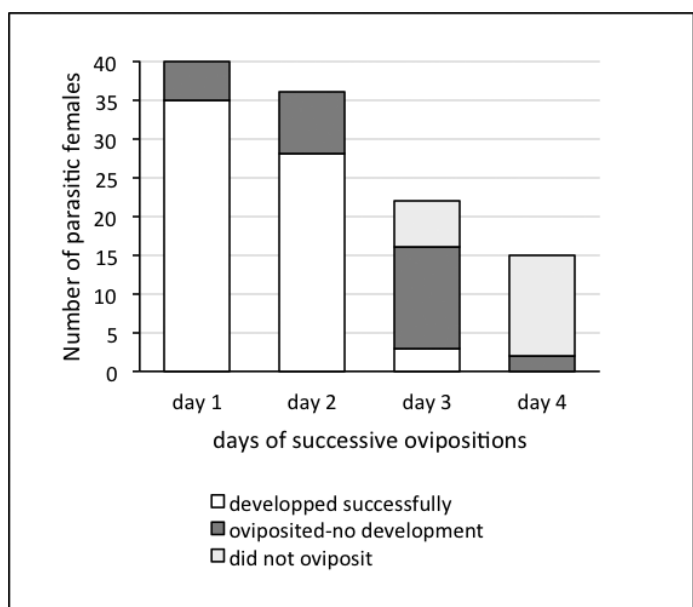
Figure 10. Issue of successive presentations of host larvae to C. typhae (one host per day for four days or less for wasps that Table 8. Development of C. typhae in Kenyan and European hosts. Bold characters indicate significant differences between host strains.